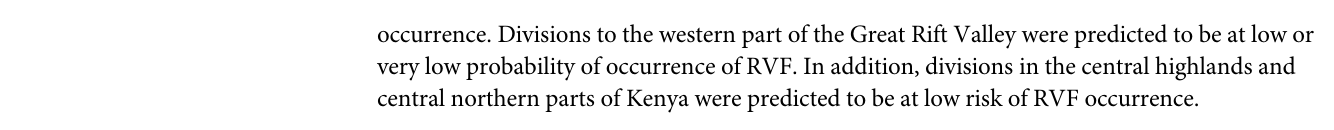
Fig 3. RVF risk map for Kenya generated from predicted probabilities by administrative divisions based on Centre Merged Analysis of Precipitation (CMAP).